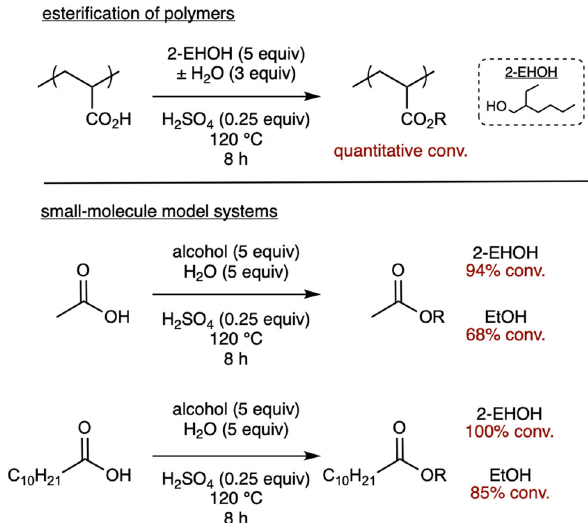
Fig. 4 Acid-catalyzed esteri fi cation. Reaction conditions and yields for acid-catalyzed esteri fi cation of poly(acrylic acid), acetic acid, and undecanoic acid.